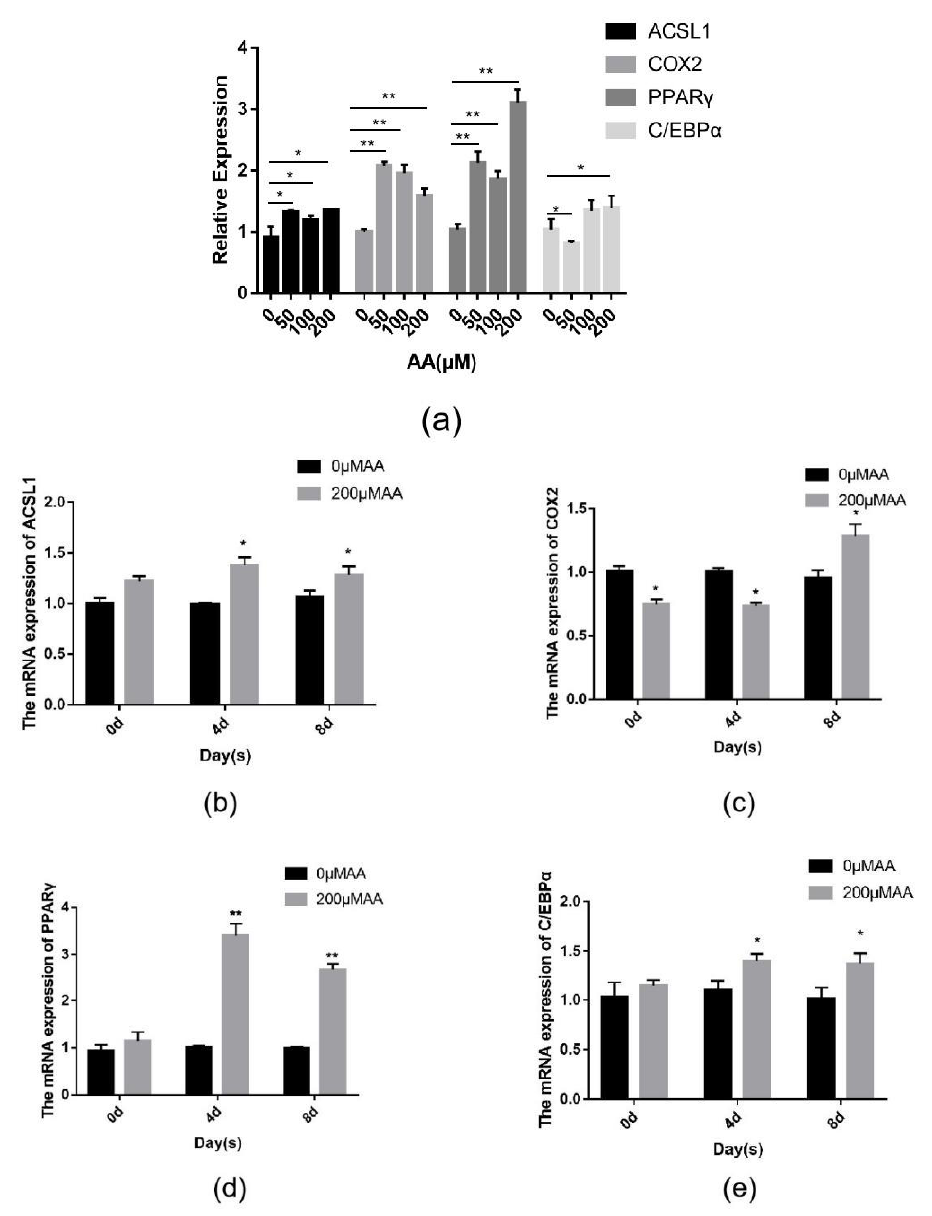
Figure 9. ( a ) ACSL1, COX2, PPARγ , and C/EBPα mRNA expression levels in sheep adipocytes with different concentrations (50, 100, and 200 μΜ) of AA on the 9th day of differentiation; ( b – e ) ACSL1, COX2, PPARγ and C/EBPα mRNA expression levels in sheep adipocytes during different stages of differentiation (* p < 0.05, ** p < 0.01).